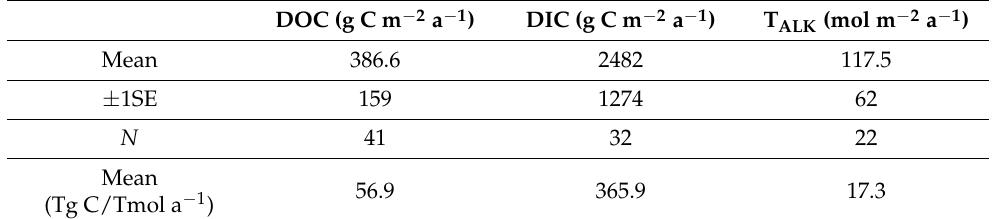
Table 2. Mean ( ± 1SE) rates of DOC, DIC, and alkalinity (T ALK ) export from the world’s mangroves assuming a global area of 147,359 km 2